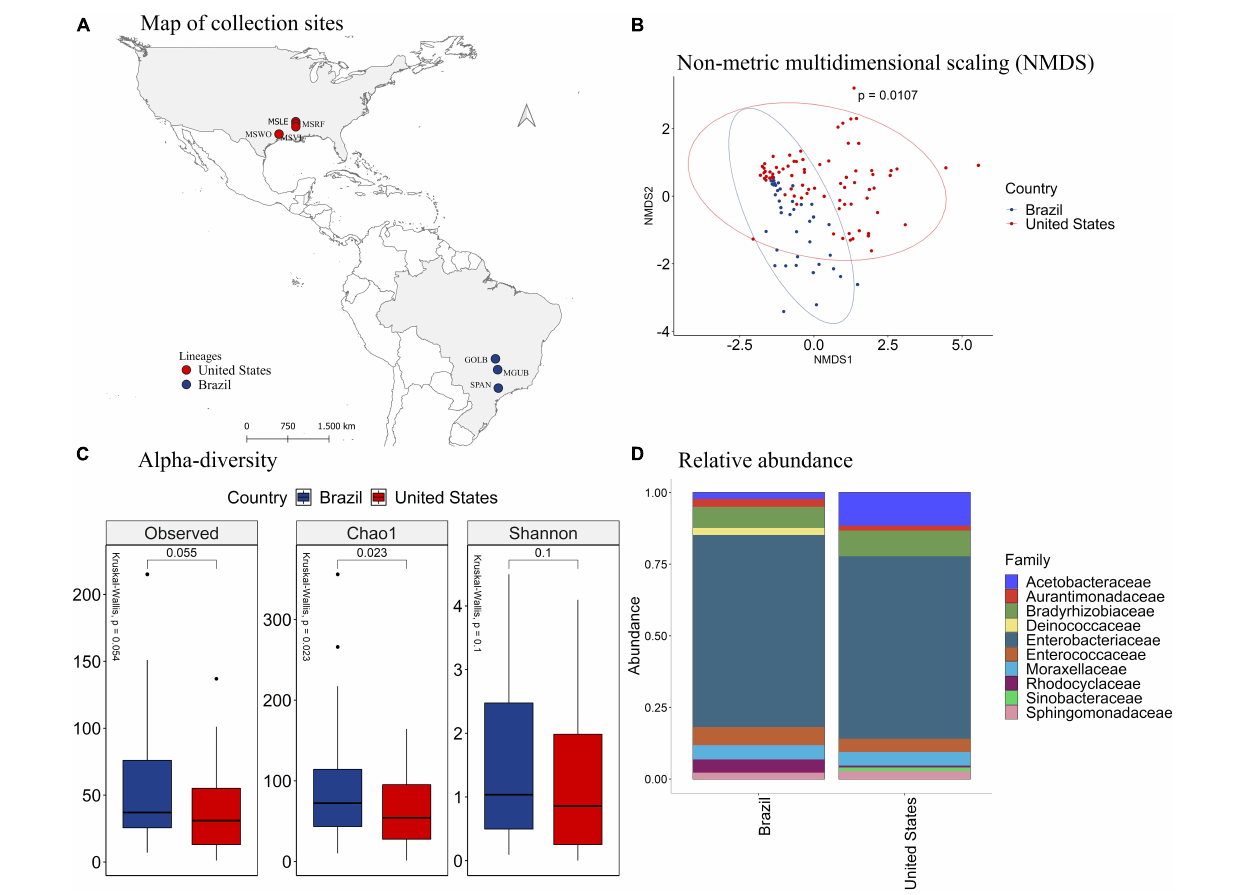
FIGURE 4 | (A) Mapping of collection sites of P. guildinii , classified by Country in Brazil and the United States (B) NMDS of Bray-Curtis similarity matrix among 117 samples from the intestinal microbiome of P. guildinii for the different countries, Brazil and United States. The ellipses are showing clustering between countries. Multivariate analysis of variance (PERMANOVA) is indicated in the upper right. (C) Alpha diversity levels based on Observed OTU, Chao1 index and Shannon index for the different countries. The non-parametric test (Kruskal–Wallis) is indicated in the upper left of each graph. Pairwise comparison (Wilcoxon) is indicated between countries. (D) Analysis of the ten most abundant bacteria families in the intestinal microbiome of P. guildinii collected in Brazil and the United States, classified by country.